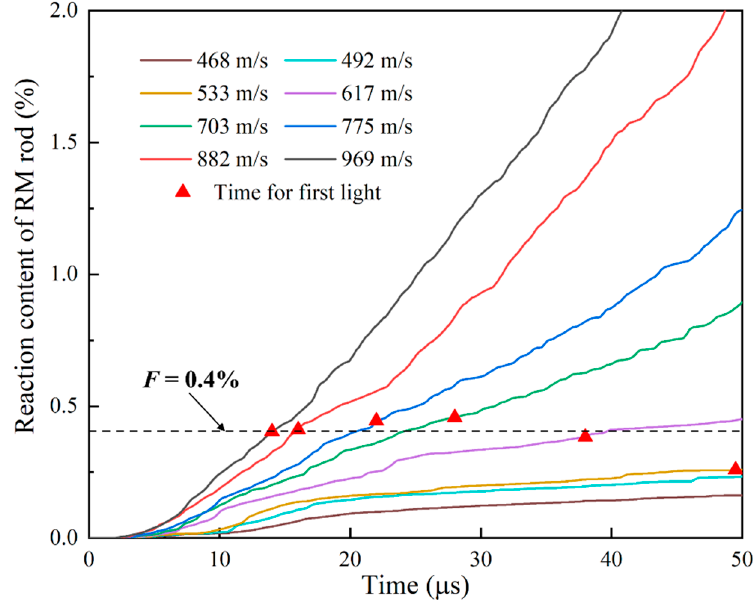
Figure 13. Reaction content of RM rods at different impact velocities.